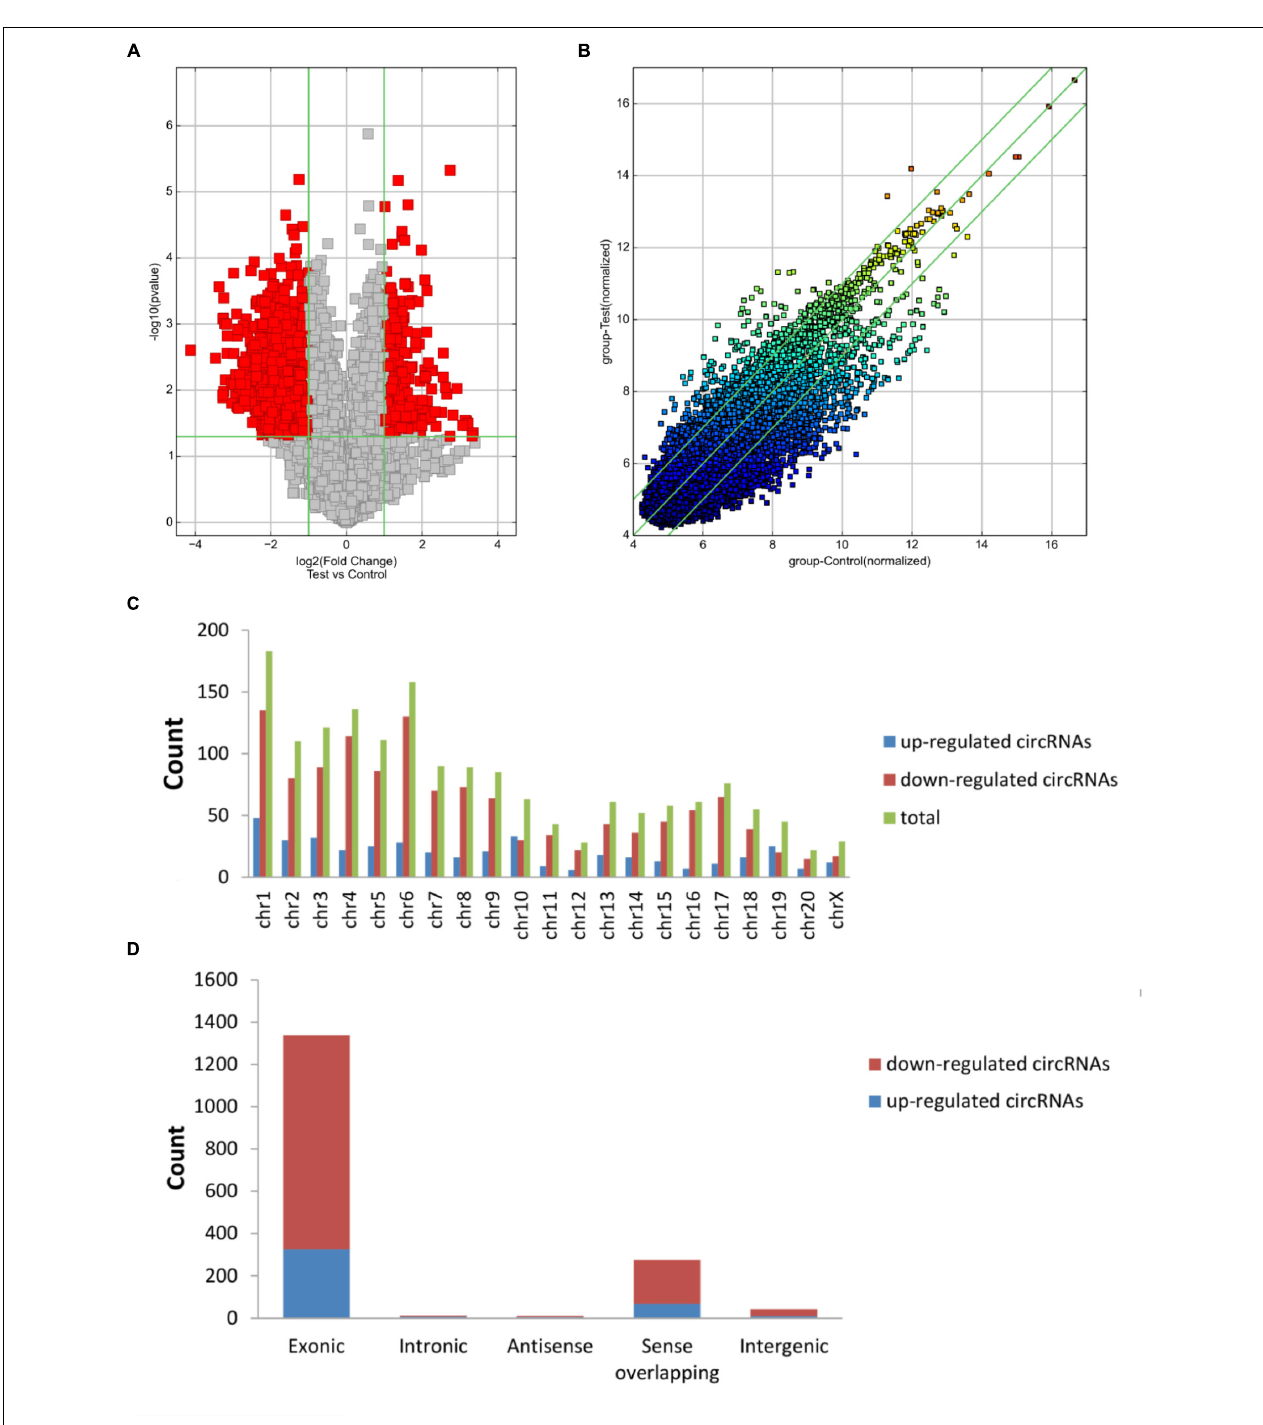
FIGURE 2 | Differences in the circRNA expression profiles between the two groups. (A) The scatter plot showed the differences in circRNA expression between the SCI and sham groups. The values of the X and Y axes in the scatter plot are the normalized signal values of the samples (log2 scaled) or the averaged normalized signal values of groups of samples (log2 scaled). The green lines are fold change lines. The circRNAs above the top green line and below the bottom green line indicated more than twofold changes of circRNAs between the two compared samples. (B) Volcano plots show the differentially expressed circRNAs with statistical significance (fold change ≥ 2; P < 0.05). The vertical lines correspond to 2.0-fold up and down, respectively, and the horizontal line represents a P of 0.05; the red point in the plot represents differentially expressed circRNAs with statistical significance. (C) The distribution of differentially expressed circRNAs in chromosomes is presented, showing that the dysregulated circRNAs stem from every chromosome. (D) The bar diagram of circRNA categories based on gene sources is shown, revealing that most of the circRNAs altered after SCI are exonic.